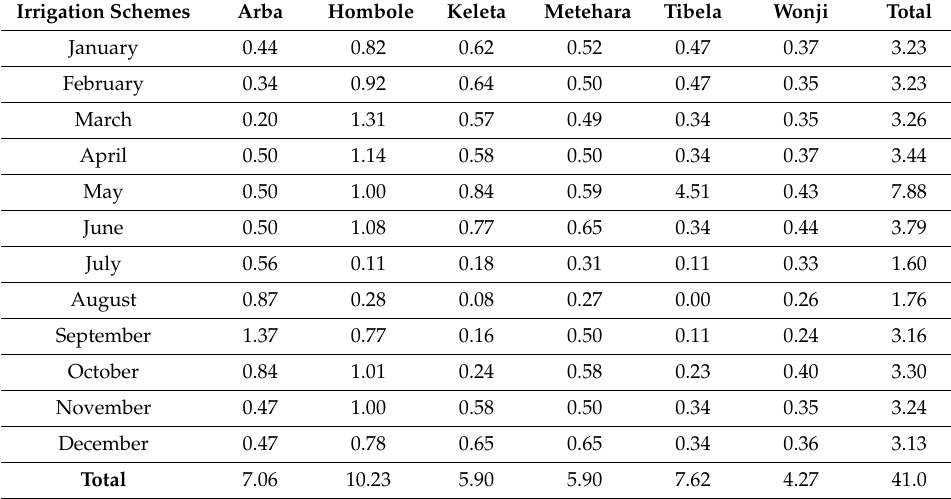
Table 2. Unmet demand across stations